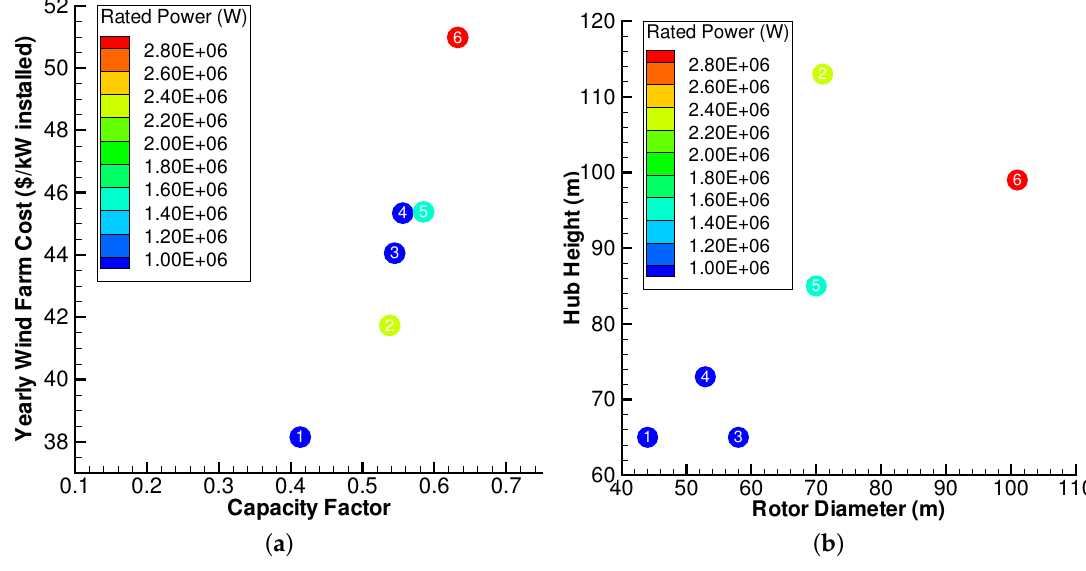
Figure 17. Tradeoffs offered by the best performing turbines of different rated powers for Case IV: Class 4–5 winds. ( a ) Best tradeoffs between the capacity factor and average annual cost ($/kW installed); ( b ) rotor diameters and hub heights of the best tradeoff